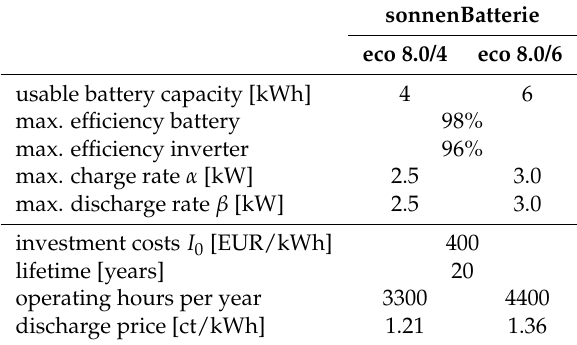
Table A2. Technical characteristics of battery storage devices (Source: sonnen GmbH and own